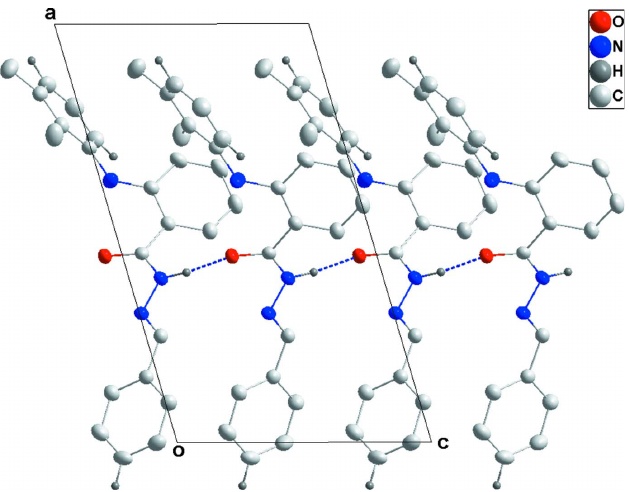
Figure 3 A portion of one N—H (cid:2)(cid:2)(cid:2) O hydrogen-bonded chain viewed along the b axis of (I) with hydrogen bonds shown as dashed